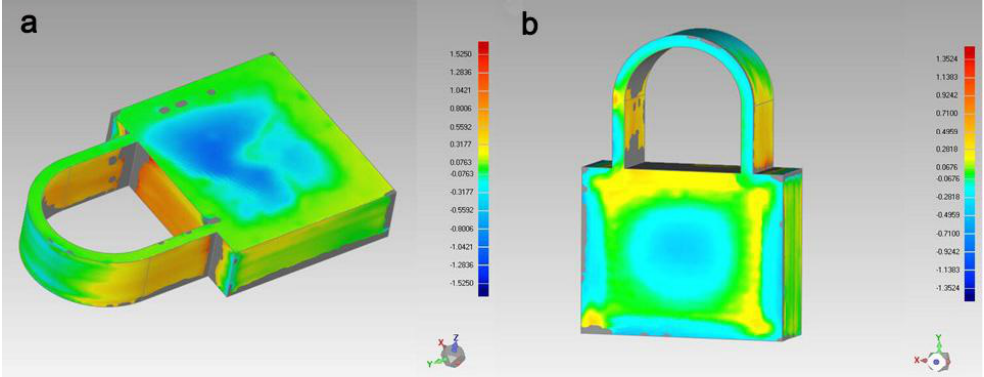
Figure 3. Deformation analysis of ( a ) printed part and ( b ) sintered part.